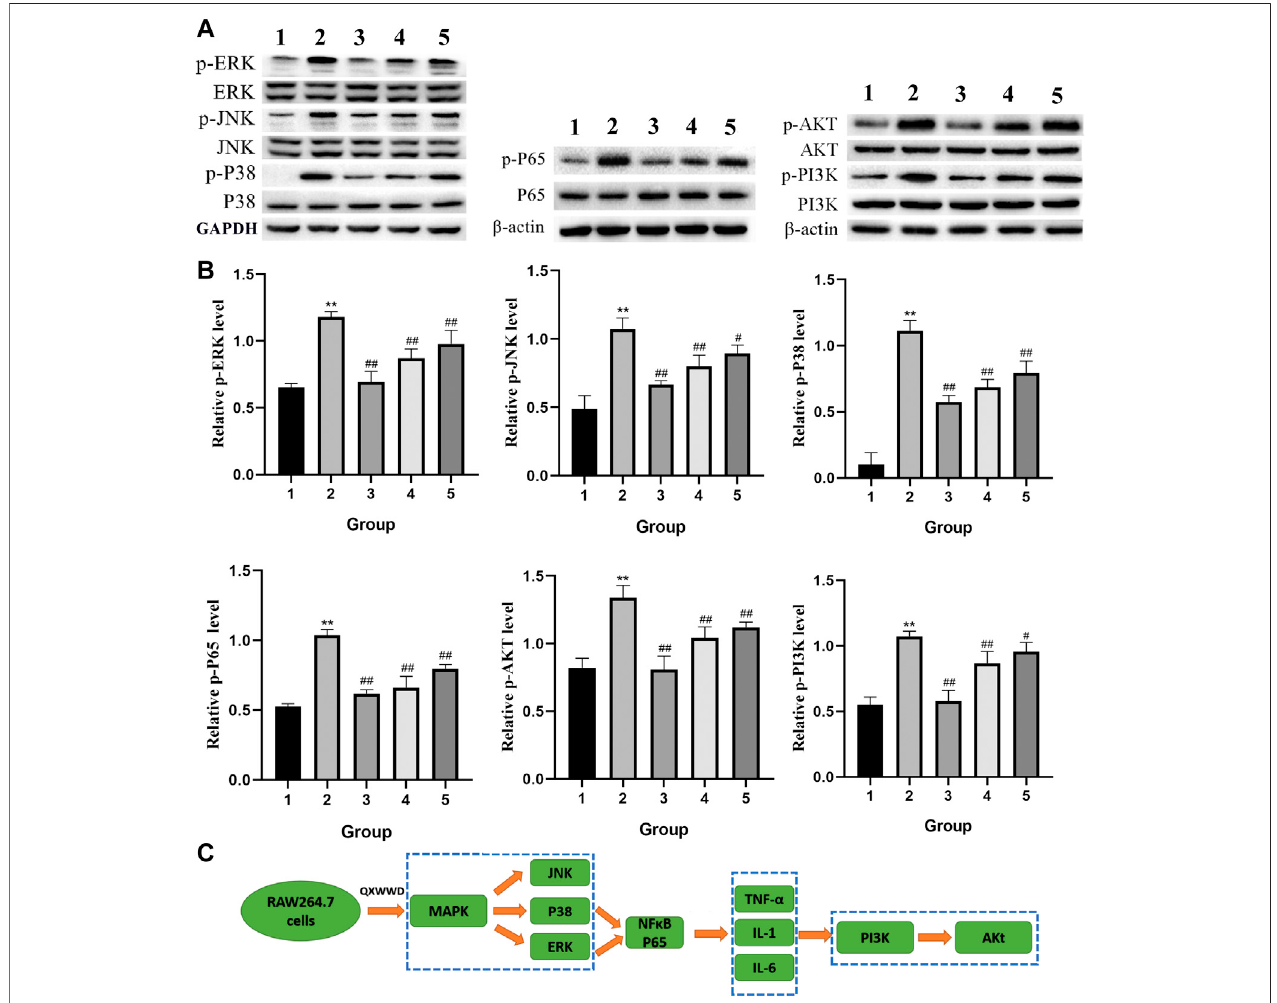
FIGURE12| QXWWDtreatmentregulatestheexpressionofkeynodesinPI3K-AktandMAPKsignalingpathwaysactivatedinRAW264.7cells1:controlgroup;2: model group (1 μ g/mlLPS);3: high dose group (80 μ g/ml QXWWD+1 μ g/ml LPS); 4:medium dose group (40 μ g/ml QXWWD+1 μ g/ml LPS); 5:low dosegroup (20 μ g/ ml QXWWD+1 μ g/ml LPS). (A) Representative bands of protein levels detected by WB, (B) The relative protein levels, (C) QXWWD regulated the PI3K-Akt and MAPK signaling pathways in RAW264.7